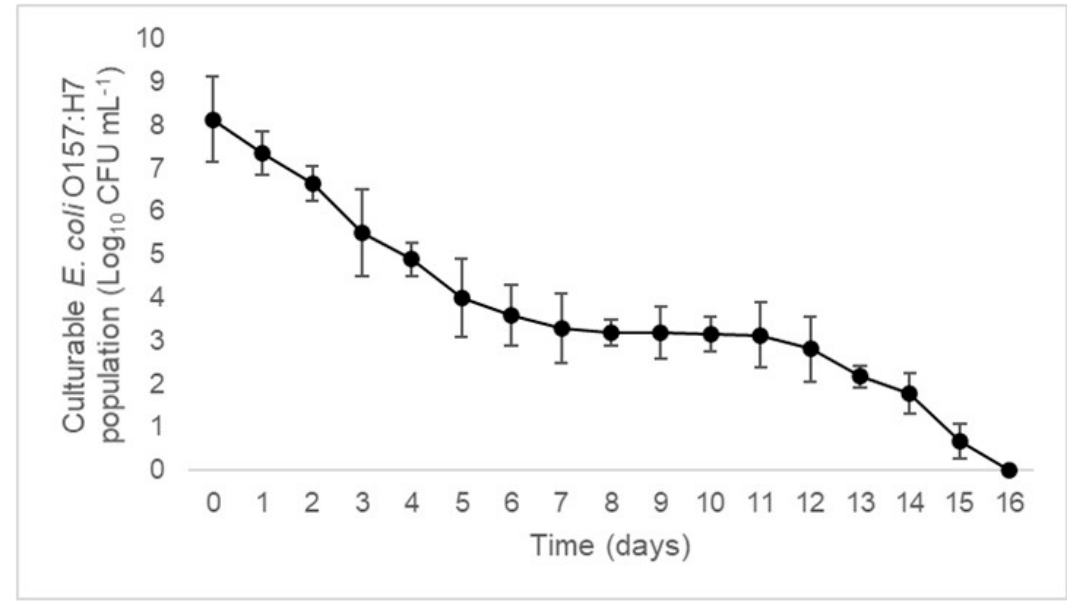
Figure 4. Decline in culturable E. coli O157:H7 (CFU mL − 1) in 7% NaCl solution at 37 °C over 16 days. ( • ) represents the mean of the viable count (n = 3) determined by plate counting. Error bars represent the standard deviation of the mean of three replicates.